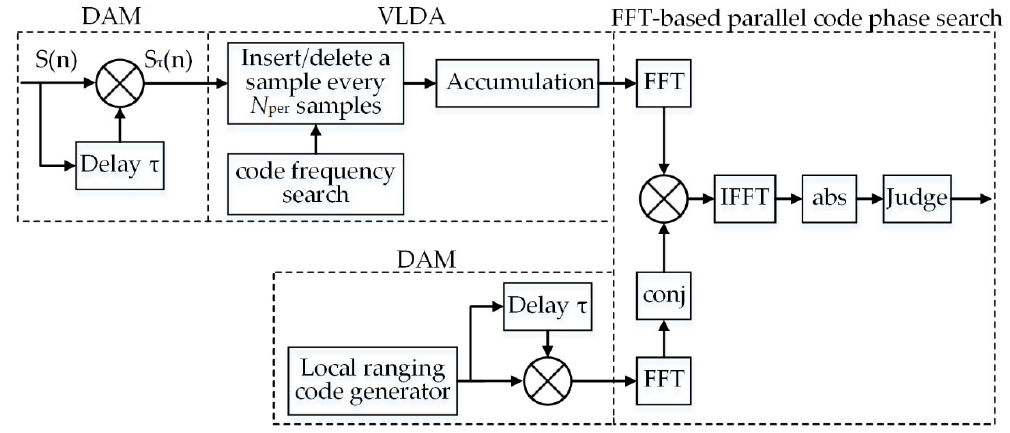
Figure 3. The DAM ‐ based variable length data accumulation (VLDA) acquisition scheme Figure 3. The DAM-based variable length data accumulation (VLDA) acquisition